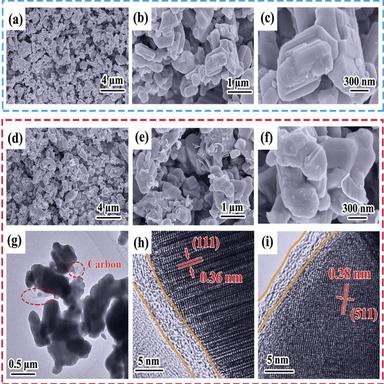
(a–c) The SEM of bulk GaNb11O29. (d–f) The SEM of GaNb11O29@C. (g) The TEM and (h–i) HRTEM of GaNb11O29@C.